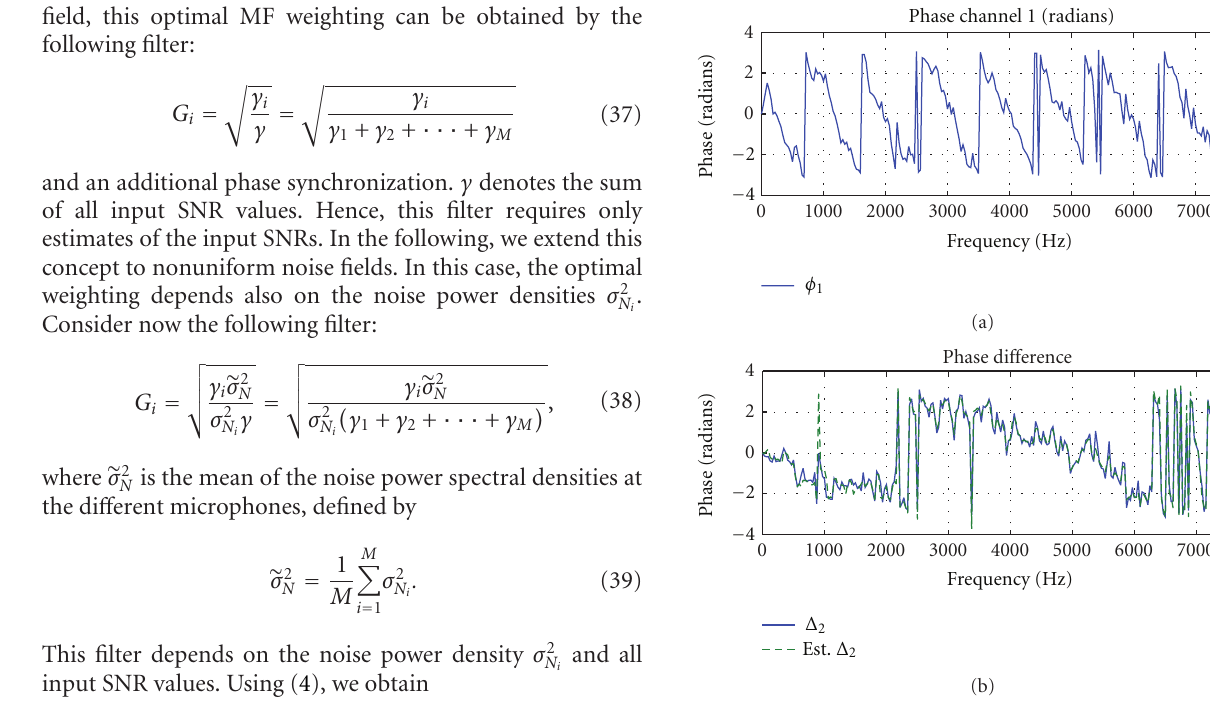
Figure 7: Actual phase of the reference channel (a) determined from the impulse response, actual phase di ff erence and estimated phase di ff erence for channel